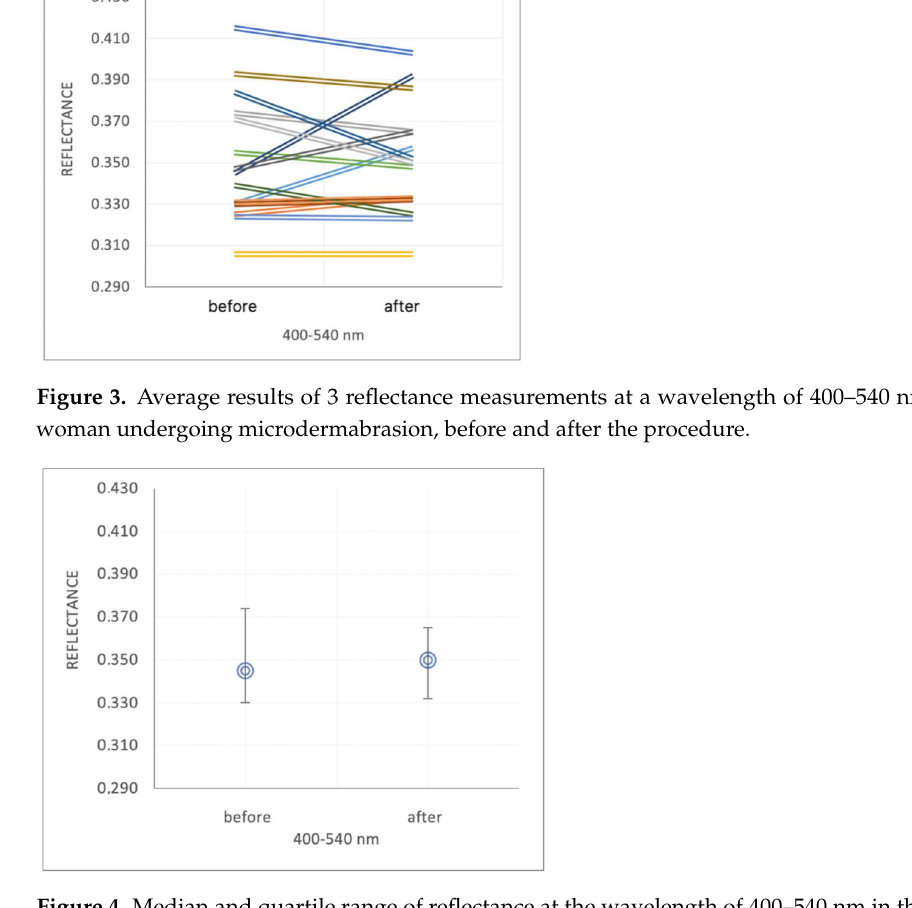
Figure 4. Median and quartile range of reflectance at the wavelength of 400–540 nm in the group of women undergoing microdermabrasion, before and after the procedure.